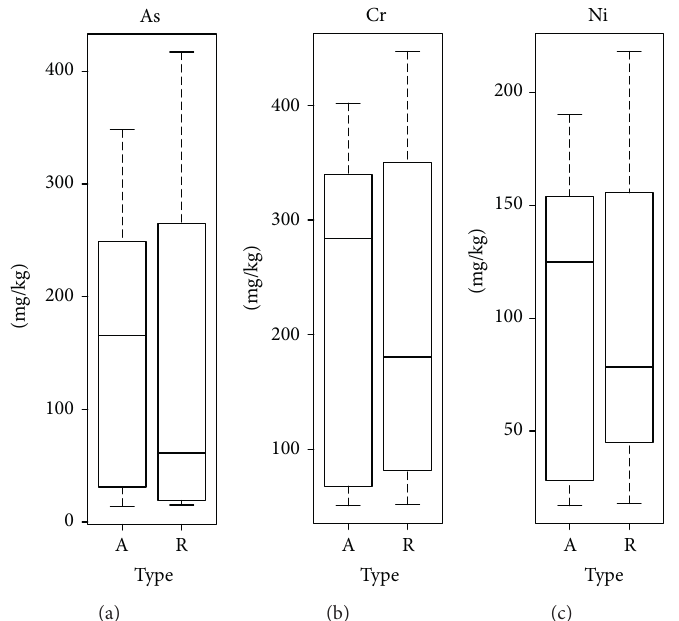
Figure 3: Box and Whisker plots for total As, Cr, and Ni concentrations stratified by location type; “A” represents allotment land use and “R” represents residential land use. The bar shows the median